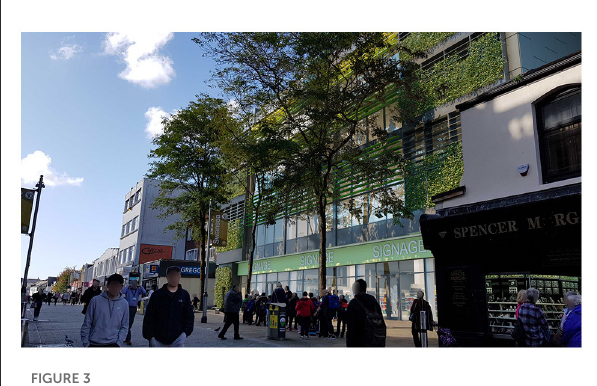
FIGURE3 Proposed front elevation of the building with green walls and retention of existing mature trees. Image used in focus group presentations and reproduced with kind permission from the